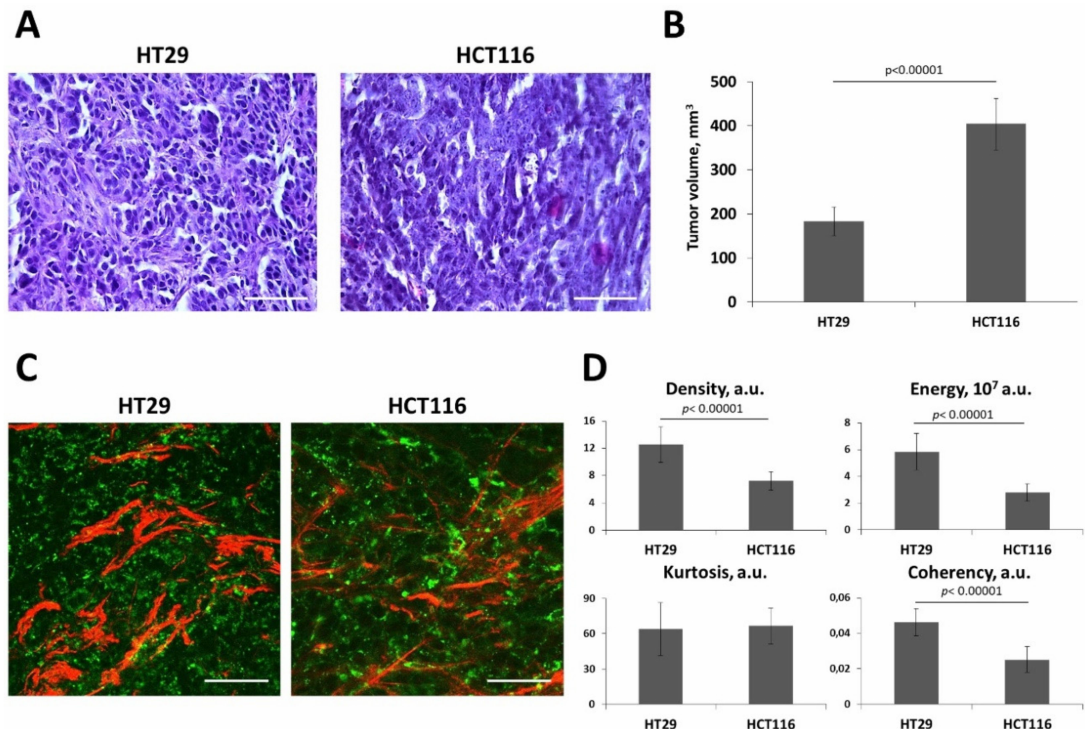
Figure 6. In vivo collagen structure in HT29 and HCT116 tumor xenograft. ( A ) Histopathology images on the 14th day of tumor growth. Hematoxylin and eosin staining. Scale bar, 50 µ m. ( B ) Tumor volume (V) measurements on 14th day of growth. Mean ± SEM. ( C ) Representative SHG images (red, collagen fibers) combined with two-photon excited fluorescence images (TPEF, green, cellular autofluorescence) of tumors. Image size is 212 × 212 µ m. Scale bar, 50 µ m. ( D ) Quantitative parameters of the SHG signal including density, energy, kurtosis, and coherency. Mean ± SEM, ( n = 3–4 tumors, at least 15 fields of view in each tumor). Cancer cells were implanted subcutaneously in nude mice. Imaging was performed on Day 14 of tumor growth. SHG images and quantitative analysis of the SHG signal show a denser and more oriented collagen structure in the HT29 compared with HCT116 tumors. p -values denote significant di ff